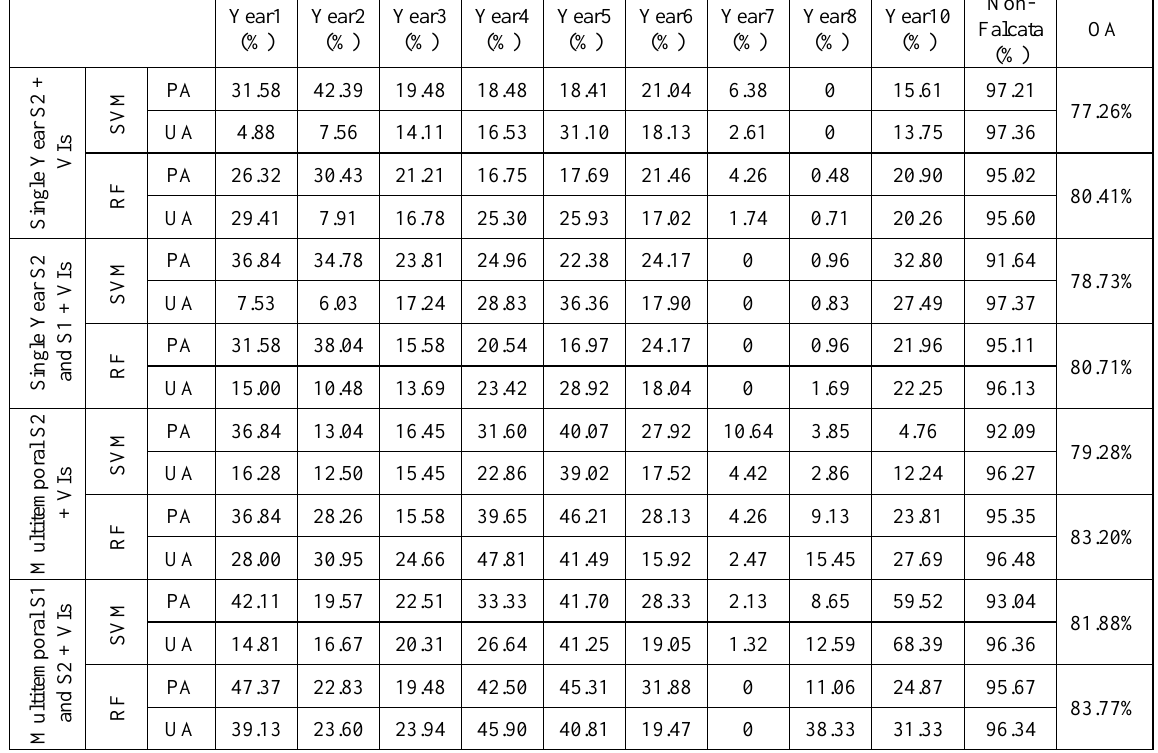
Table 6 . Accuracies of the machine learning classification based Falcata stand age estimations, with elevation and slope as additional bands.